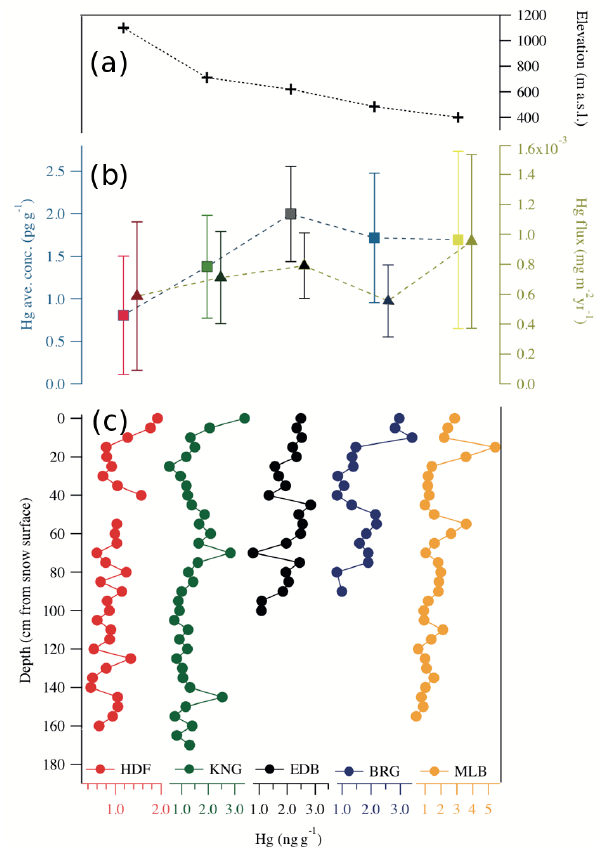
Figure 13. The (a) elevation of the snow pit sampling sites. Panel (c) depicts Hg concentrations in the annual snowpack (pgg − 1 ). The depth scale is expressed in centimeters, and the snow surface is set at 0cm. Samples have a constant resolution of 5cm to the bottom. (b) Mean Hg concentration (color square) and total flux (color tri- angles); vertical bars indicate 1 standard